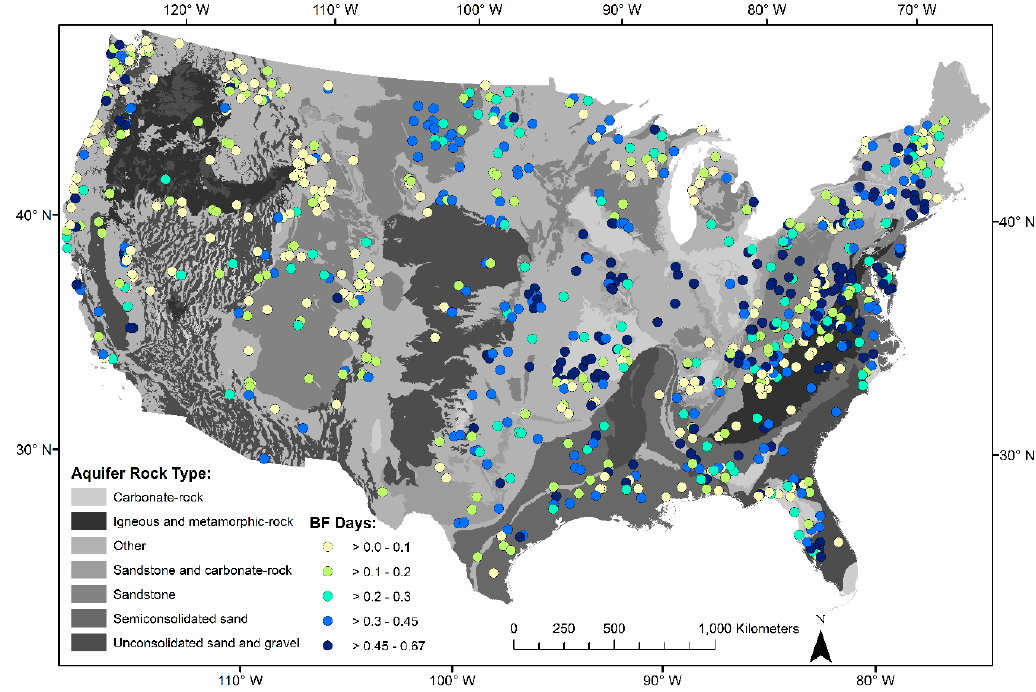
Figure 7. Spatial distribution of BF Days (fraction) of sites with accepted OHS models (n = 825), presented among aquifer type within the CONUS. The western US has a generally smaller fraction of days at base flow on average than the Midwest and eastern